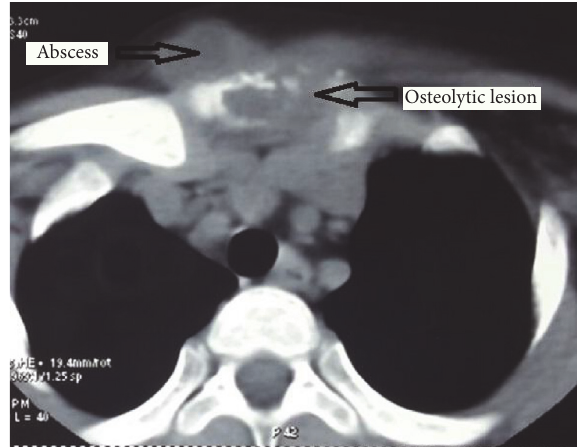
Figure 2: Computed tomography image demonstrating lytic destruction of manubrium with overlying peripherally enhancing soft tissue which is suggestive of osteomyelitis of the manubrium with abscess formation in the adjacent